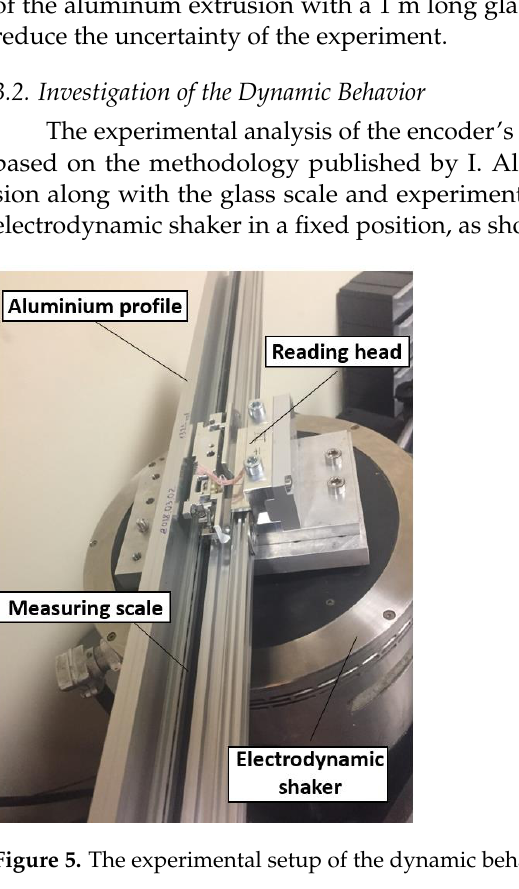
Figure 4. The reading head of the linear encoder mounted on the linear comparator with the yaw inaccuracy achieved by a steel gauge block.